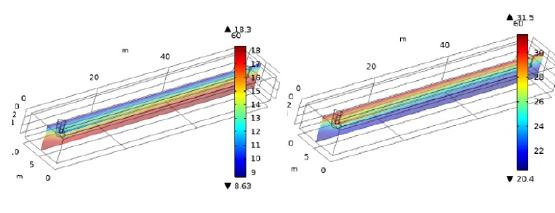
mm is considered as surface roughness.